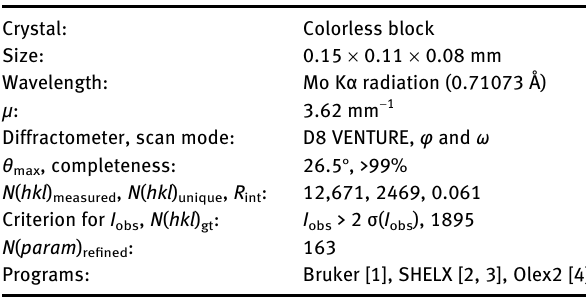
Table  : Data collection and